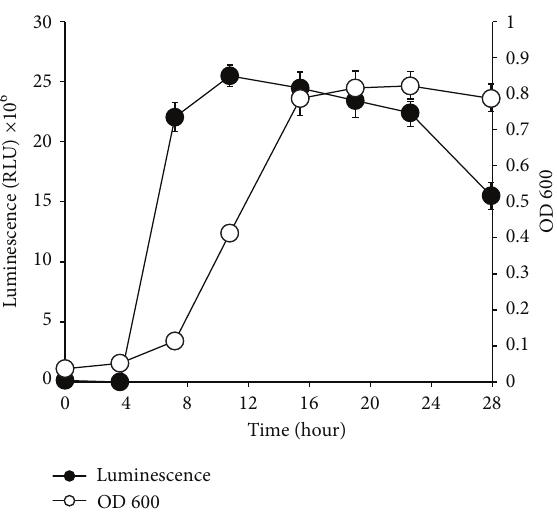
Figure 9: Bioluminescence production and bacterial growth of Photobacterium sp. strain MIE in luminescence media over time. The isolate was grown in luminescence media and incubated in an orbital shaker (100rpm) for 28 hours at room temperature. Biolumi- nescenceproduction(blackcircle)andbacterialgrowth(circle)were determined using Beckman Counter DTX 800 multimode detector. The error bars represent the mean ± standard deviation of three replicates.